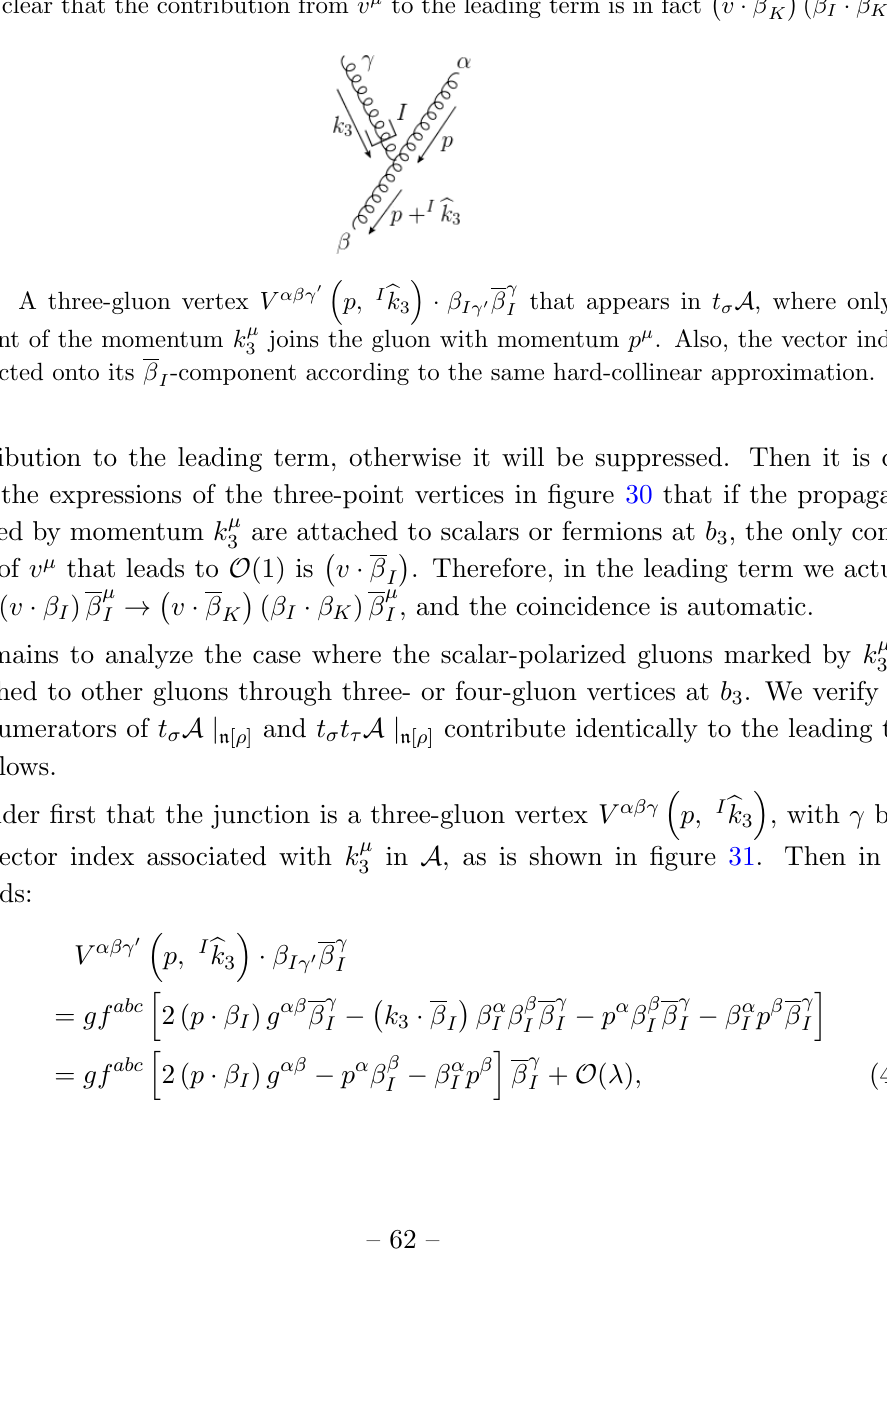
does not appear 3 (cid:22) in (cid:26) f (cid:27) g , and after the hard-collinear approximation I (cid:22) (cid:0) (cid:1) v (cid:1) (cid:12) ( (cid:12) I (cid:1) (cid:12) K ) (cid:12) . K I